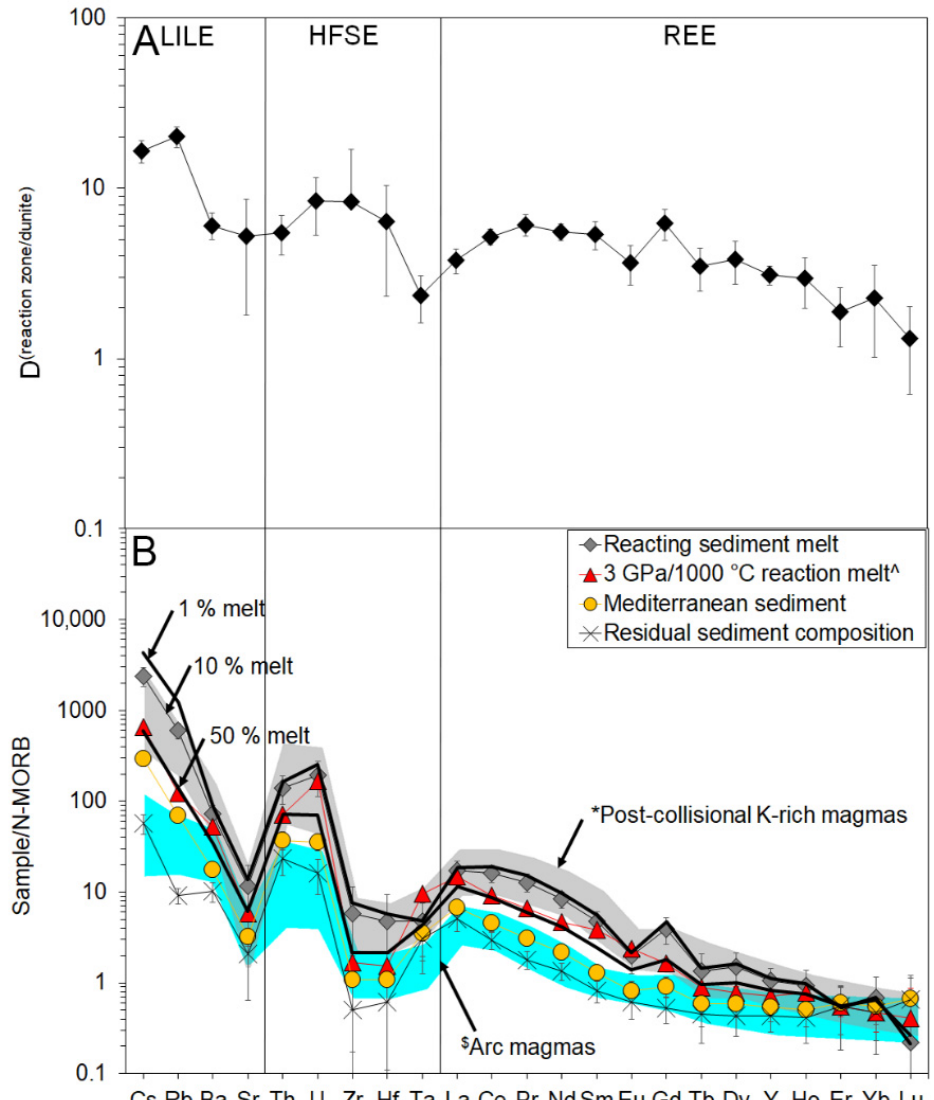
Figure 4. Element fractionation within the reaction zone. ( A ) Element distribution plot, showing element enrichment factors (D) calculated from LA-ICP-TOFMS raw counts in the reaction zone normalized to the depleted peridotite (dunite). ( B ) N-MORB normalized trace element contents [44] of the original sedimentary rock and the calculated metasome composition compared to post-collisional K-rich magmas [19,20]. The enrichment factors from ( A ) were used with the fractional melting equation [43] to calculate the trace element concentrations of the infiltrating and reacting melt. The metasome represents a 1–50% fractional melt of the sediment which reacts out completely as it infiltrates the dunite. The calculated composition of this reacting sediment melt is close to the observed array of trace elements of post-collisional K-rich magmas which are sourced from sediment-melt metasomatized mantle * [13,23], while the calculated residue of this reaction plots within the compositional range of arc magmas $ [45]. The trace element pattern of the 3 GPa/1000 °C reaction melt ^ [32], where the sediment melted to ~30%, plots within this calculated 1–50% range.